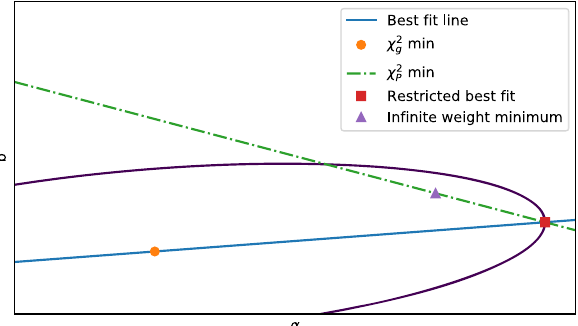
Fig. 6 Same as Fig. 5, but now for a toy model in which process P does not fully determine the PDFs. The minimum of the global χ 2 g is the orange circle while the minimum of the χ 2 for process P is the P dashed green line. The solid blue line is the best-fit line as in Fig. 5. The P : the value of α red square is the “standard” value α r s corresponding 0 2 , i.e. the point with lowest χ 2 to lowest restricted χ r along the best-fit P P line. The ellipse is a fixed χ 2 g contour